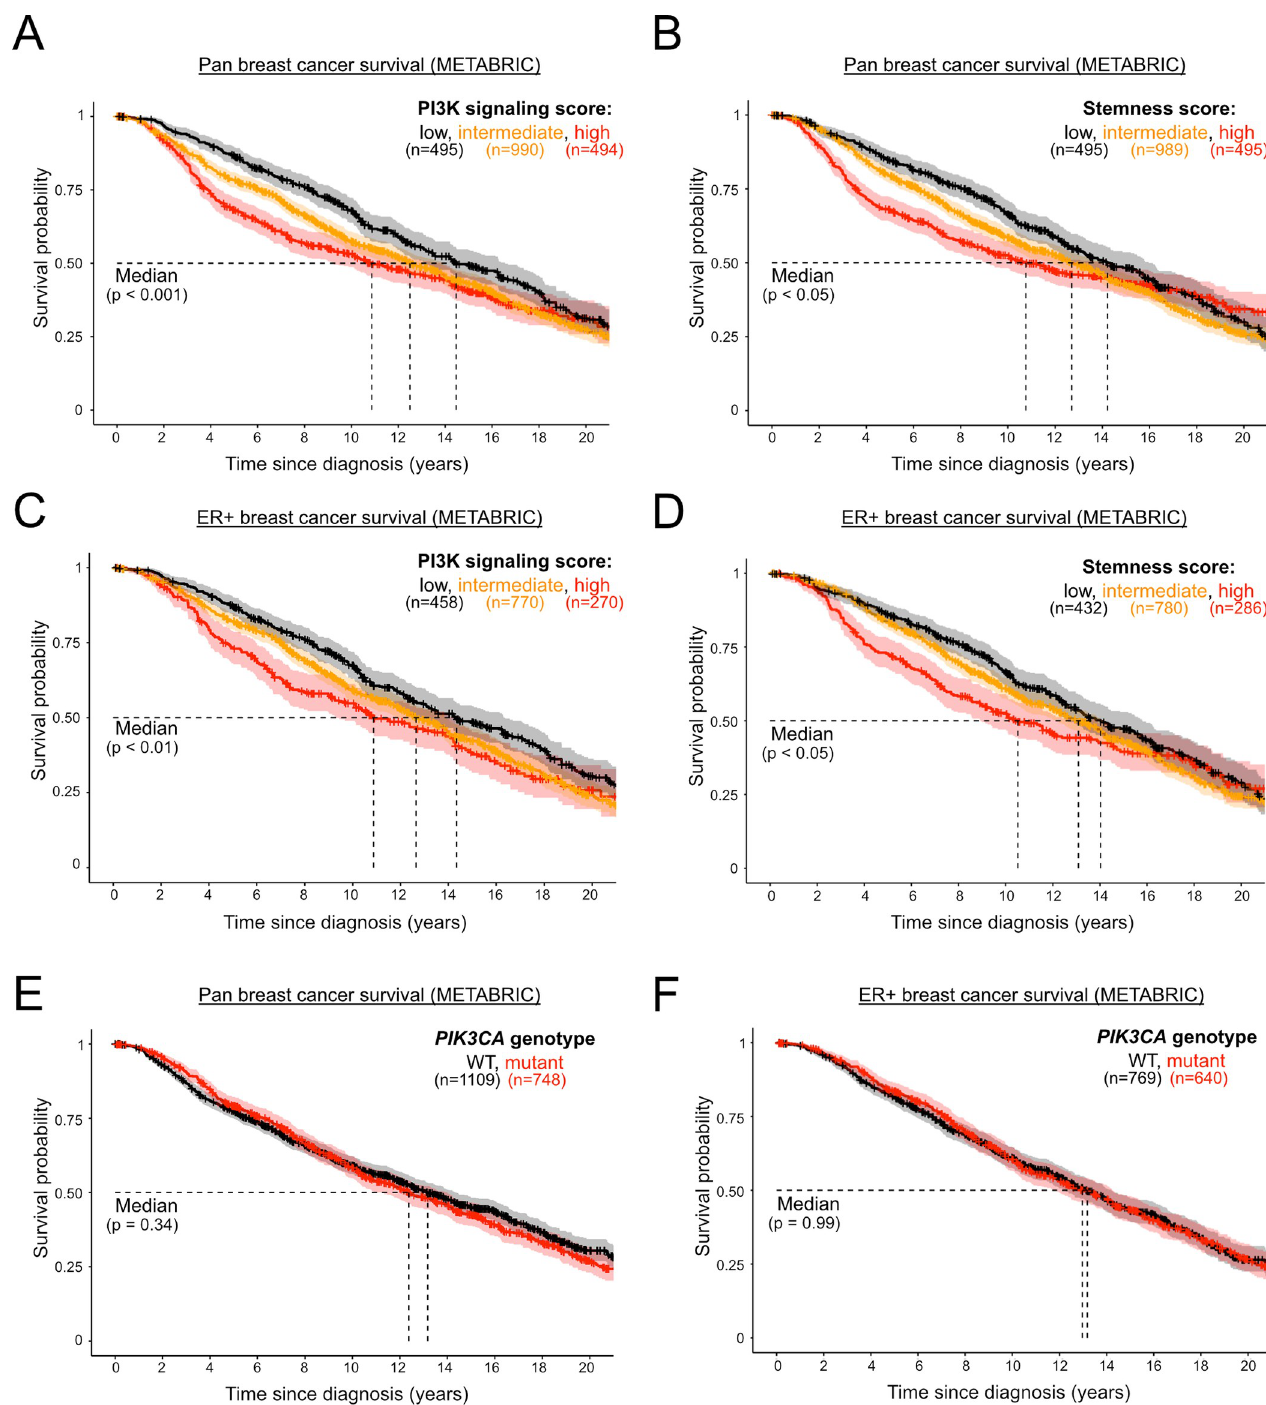
Fig 4. PI3K signaling and stemness scores, but not PIK3CA genotype, are prognostic in ER+ breast cancer. Pan-breast cancer patient survival in METABRIC, as a function of PI3K signaling (A) or stemness (B) score. Survival analysis in estrogen receptor (ER)-positive breast cancer patients, as a function of PI3K signaling (C) or stemness (D) score. Low, intermediate and high classifications represent the bottom quartile, the interquartile range and the top quartile of the respective scores. (E) and (D) represent pan- and ER-positive breast cancer patient (METABRIC) survival, respectively, as a function of binary PIK3CA genotype. The mutant genotype captures only cases with activating missense mutations. The sample size for each panel and subgroup is indicated, and p-values were calculated using a log-rank test. The 95% confidence intervals are indicated by shading.